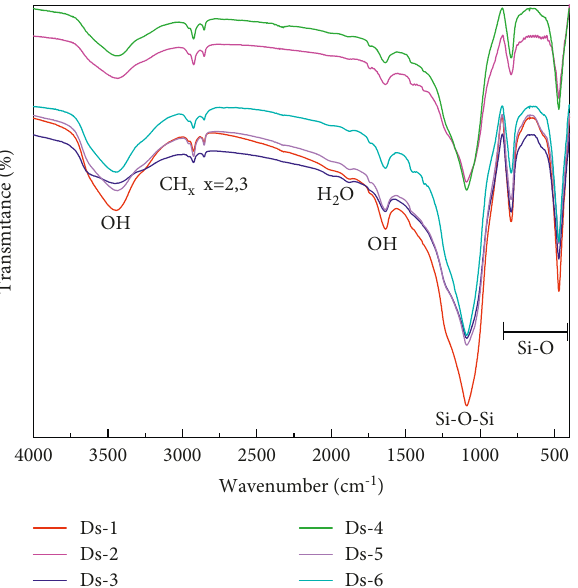
Figure 6: FTIR spectra profiles of opal samples: Ds-1, Ds-2, Ds-3, Ds-4, Ds-5, and Ds-6. Table 2: Concentration (in ppm) for trace elements within each opal sample by ICP-OES (Ds-1: Workwasha, Ds-2: Alehuat, Ds-3: